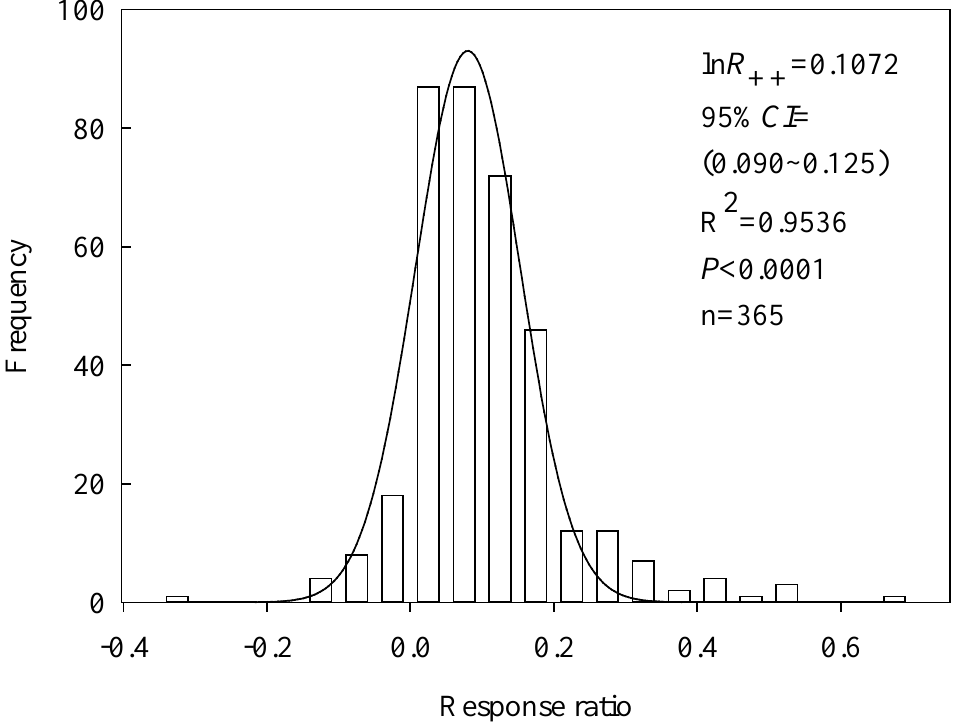
Figure 1. Frequency distributions of response ratios (ln R ) for SOC storage responding to RR. The fitted curve is an estimated Gaussian distribution in frequency. The dashed line is at In R ++ = 0, 95% CI indicates the 95% confidence interval, and n is the number of comparisons. In R ++ ±95% CI does not overlap 0 means p < 0.05.